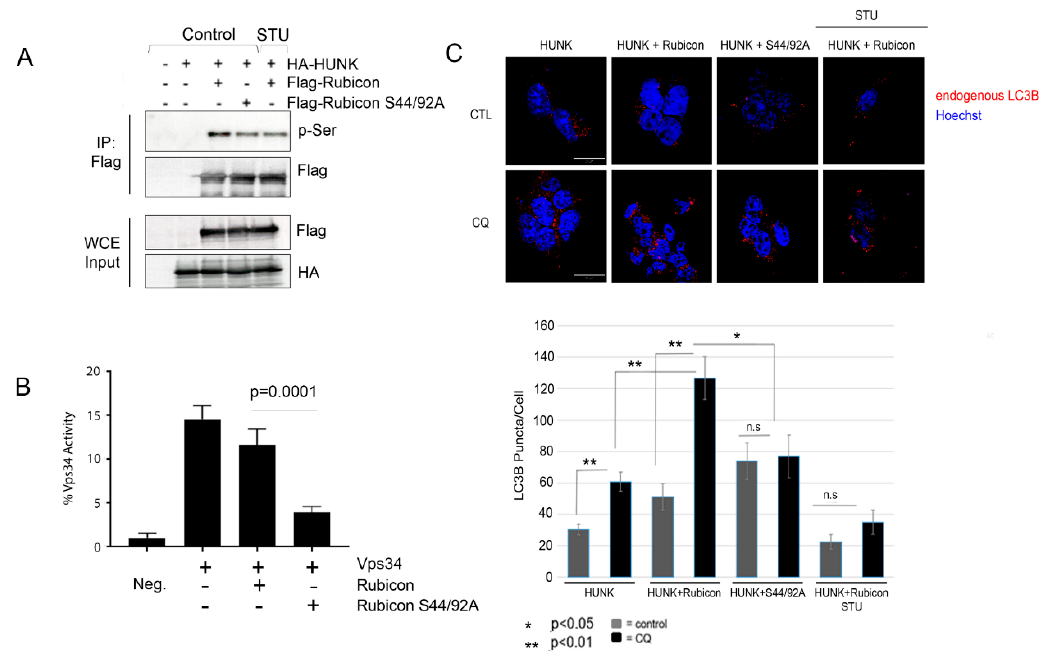
Figure 5. Autophagy is impaired in cells expressing WT HUNK and S44A/S92A Rubicon. ( A ) HA-HUNK and Flag-Rubicon WT or Flag-Rubicon S44A/S92A were expressed in 293T cells. The next day, cells were treated with either vehicle (DMSO-Control group) or 100 nM STU for 1 h prior to lysing. Rubicon was isolated by Flag immunoprecipitation and immunoblotted for p-Ser and Flag. Whole cell extracts (WCE) were immunblotted for Flag and HA to confirm HUNK and Rubicon expression. ( B ) Flag-Vps34 was expressed with WT Rubicon or S44/92A Rubicon. Vps34 was isolated by Flag immunoprecipitation and incubated with PI substrate in a kinase reaction. Percent Vps34 activity is a quantitation of PI to PI(3)P conversion. Data represents 3 individual experiments. Student’s T -test was performed on n = 6 replicates, p = 0.0001. ( C ) HA-HUNK was expressed with WT Rubicon or S44A/S92A Rubicon in 293T cells. The following day cells were serum deprived and treated with 100 µM chloroquine (CQ) for 4 h and then (DMSO) or 100 nM STU for 1 h prior to imaging. Representative images shown (top) with quantitation of the number of endogenous LC3B puncta per cell (bottom). N ≥ 3 fields per experiment. Data represent 3 or more experiments. Student’s T -test was used to perform statistical analysis. Scale bar size = 10 µm, not significant ( n.s.) .